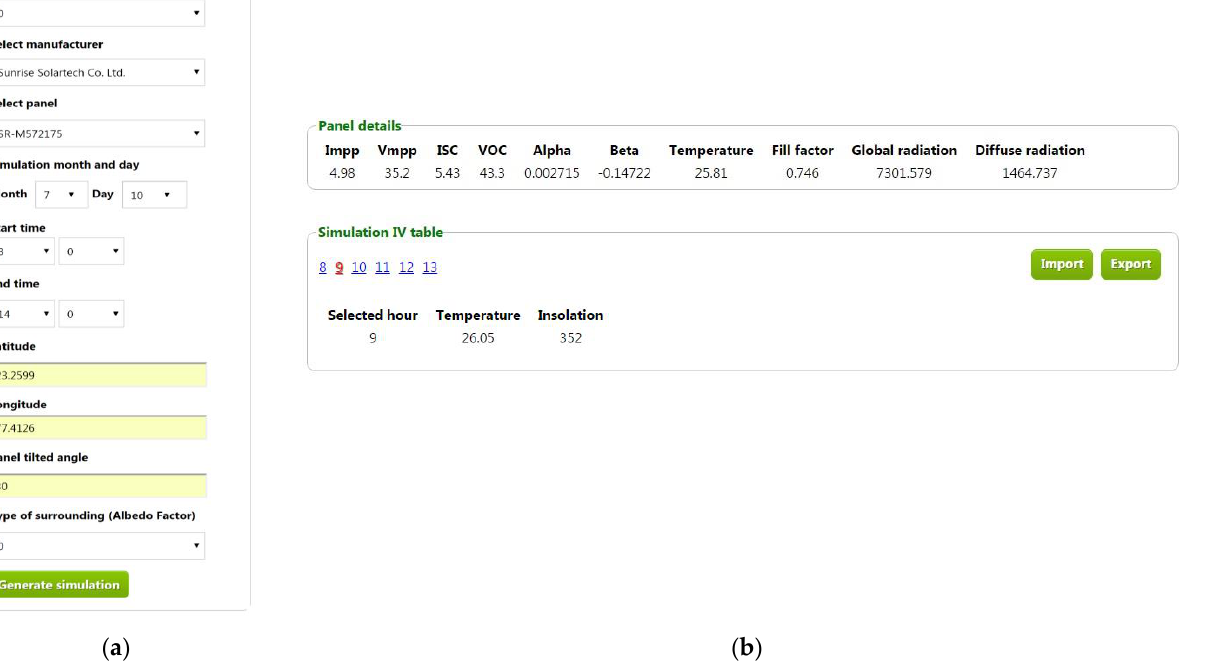
Figure 11. ( a ). Specification of the array taken for testing. ( b ). Specification of the array uploaded in the PV emulator.